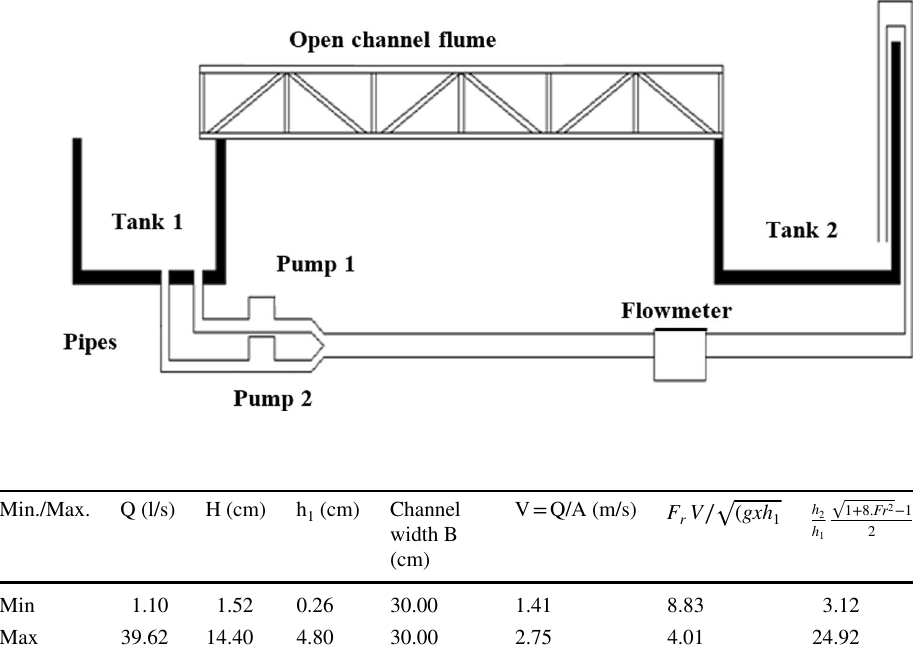
Fig. 5 Schematic view of open- channel flume